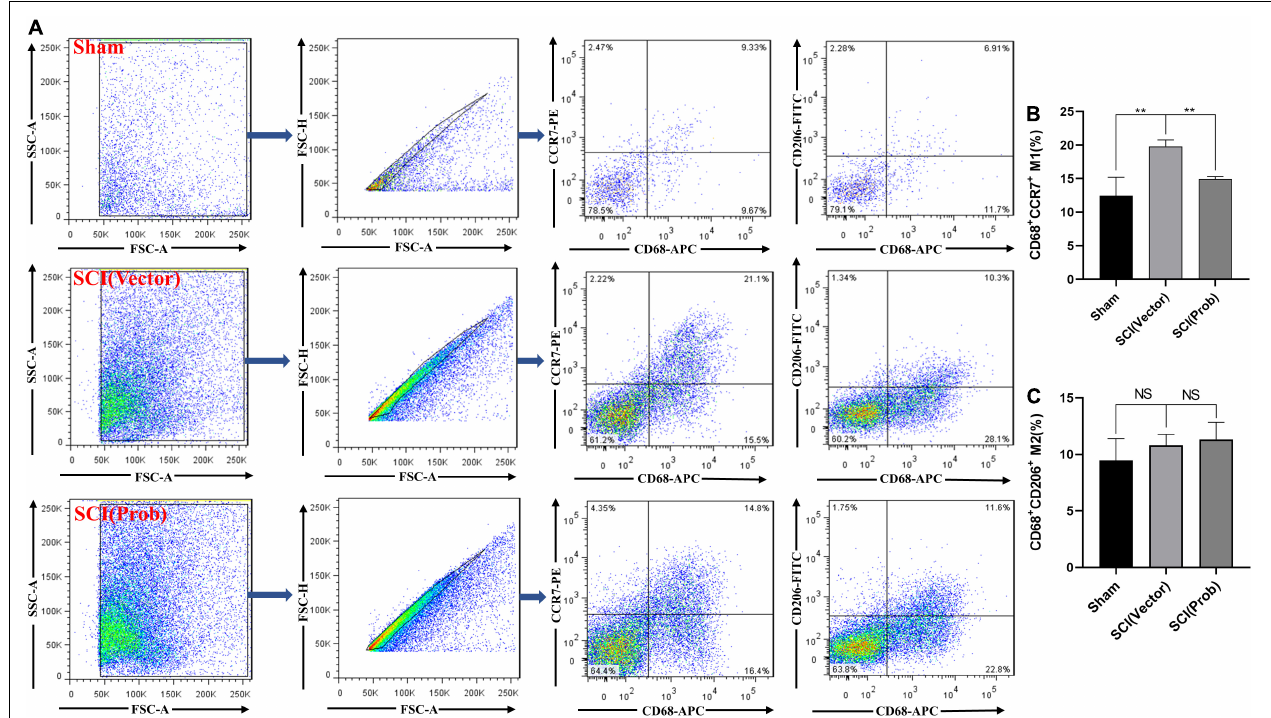
FIGURE 4 | Effects of Probenecid on Polarization of M1 and M2 in the injured spinal cord as distinguished by flow cytometr (FCM). CD68 + CCR7 + and CD68 + CD206 + cells were defined as M1 and M2, respectively. (A) Flow cytometry pictures of cells derived from spinal cord homogenate. (B,C) Statistical charts (** p < 0.01 n =